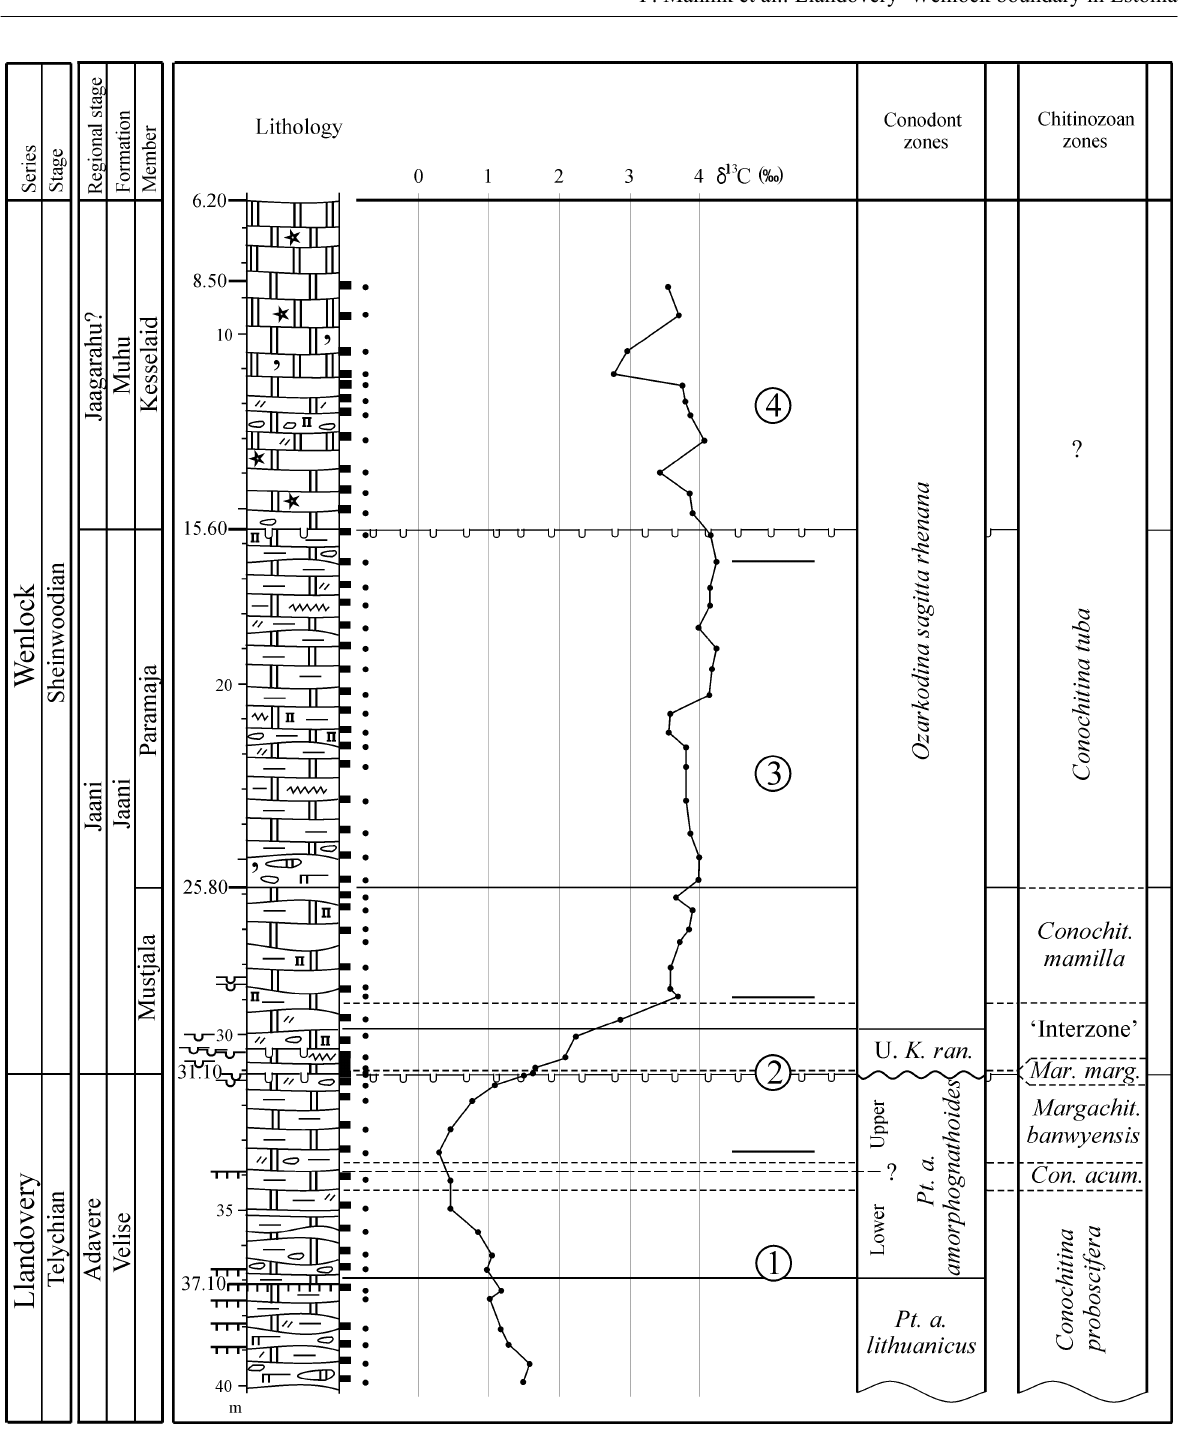
Fig. 6. Carbon isotopes and integrated biostratigraphy in the Suigu (S-3) core section. Dots just right of the micropalaeontological samples indicate the levels of δ 13 C analyses; numbers in circles right of the δ 13 C curve indicate characteristic intervals of the curve discussed in the text. U. K. ran. , Upper Kockelella ranuliformis ; Pt. a. , Pterospathodus amorphognathoides